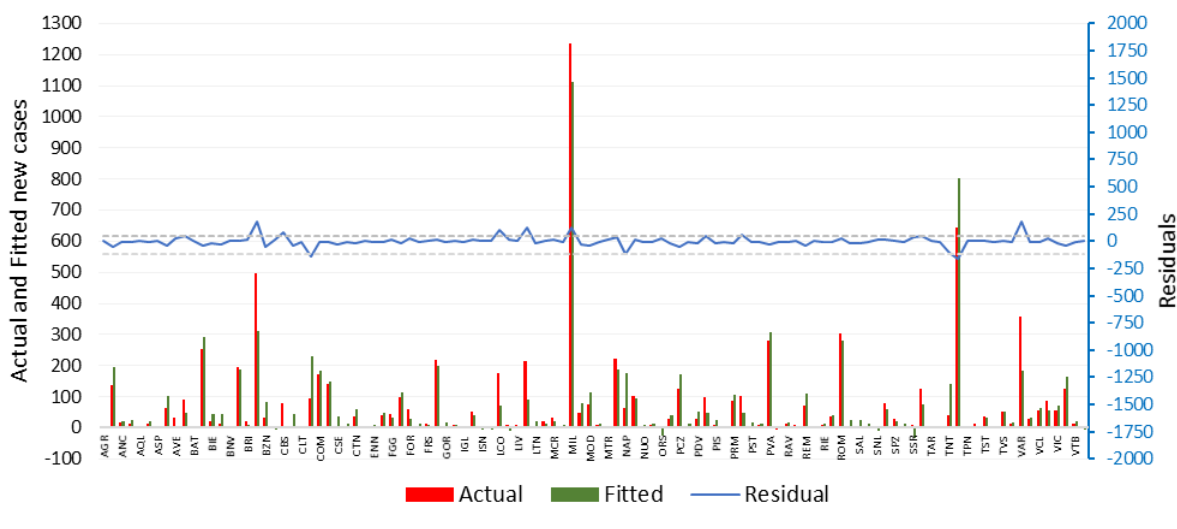
Figure 11. Residuals of colocation (Equation 11) model, week